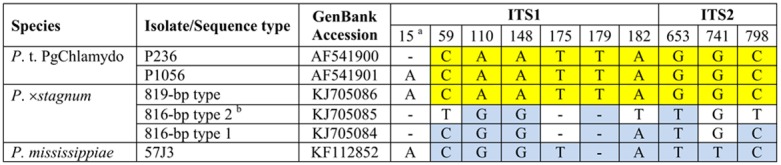
Internal transcribed spacer (ITS) sequence alignment of Phytophthora ×stagnum, P. mississippiae and P. taxon PgChlamydo.Position numbers are given based on the alignment. Yellow indicates sequences belong to P. taxon PgChlamydo authentic isolates. Blue indicates sequences belong to P. mississippiae type isolate 57J3. aPosition 15 is in the poly(A) region of ITS 1, which may contain sequencing errors. Thus, it is excluded from the analysis of hybridization. However, the indel of position 15 among three types of P. ×stagnum clones explains continual polymorphism and unreadable sequences of the ITS 1 regions amplified with the forward primer ITS6F in the initial sequencing before cloning. bType 1 and 2 occurred 21 and 10 times among 31 clones producing 816-bp sequences.